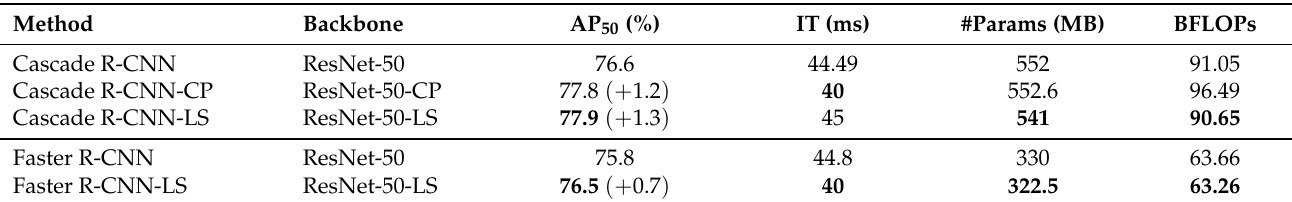
Table 3. Experiment results on DOTA with Cascade R-CNN and Faster R-CNN as baselines. The postfixes of “CP” and “LS” in the Method column indicate the different sparse density feature extraction modules in the network, which are pooling after extraction and the proposed lifting scheme layer, respectively. The evaluation metrics include detection performance metrics of average precision at IOU threshold = 0.5 (AP 50 ) and network efficiency metrics of inference time (IT), the number of parameters (#params), and billion float operations (BFLOPs). The values in the parentheses in the AP 50 column represent the increment compared with the baselines. The best results are in bold